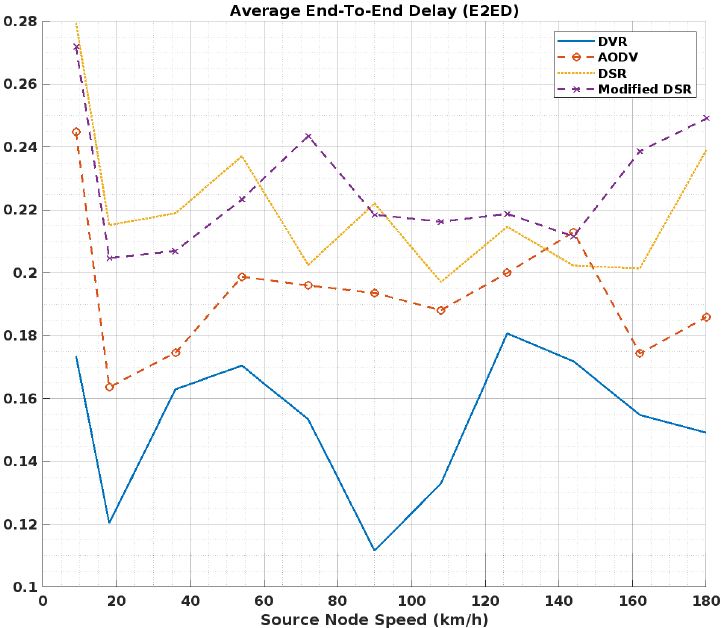
Figure 5. End-to-end delay (E2ED) as a function of the source node’s speed for the DVR, AODV, DSR, and Modified DSR